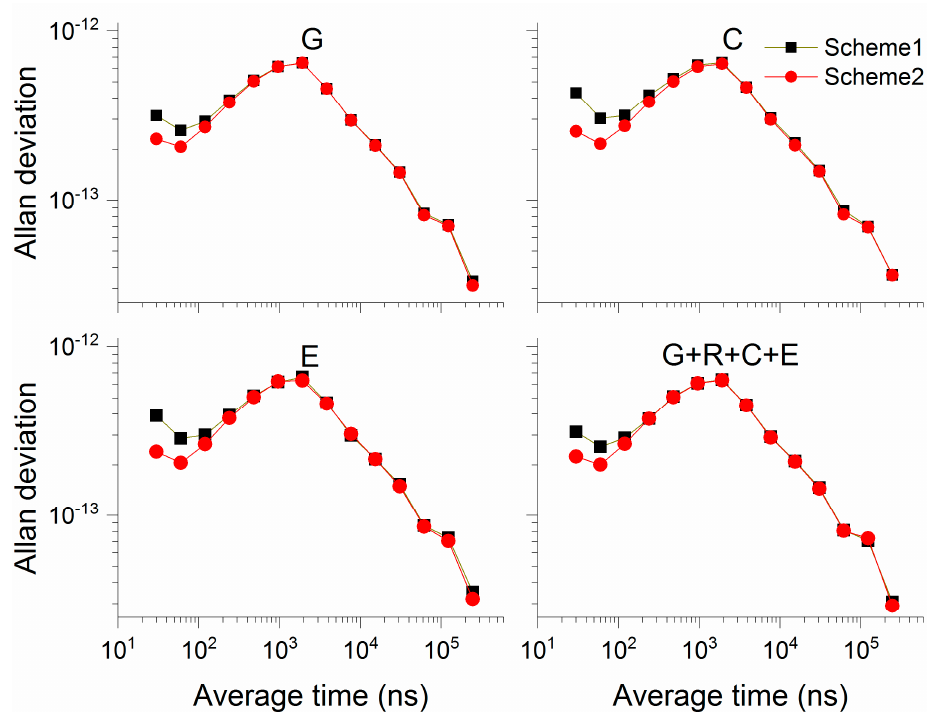
Figure 18. Allan deviation of scheme1 and scheme2 on HARB-NTSC with single-system and multi-GNSS models using GBM products.